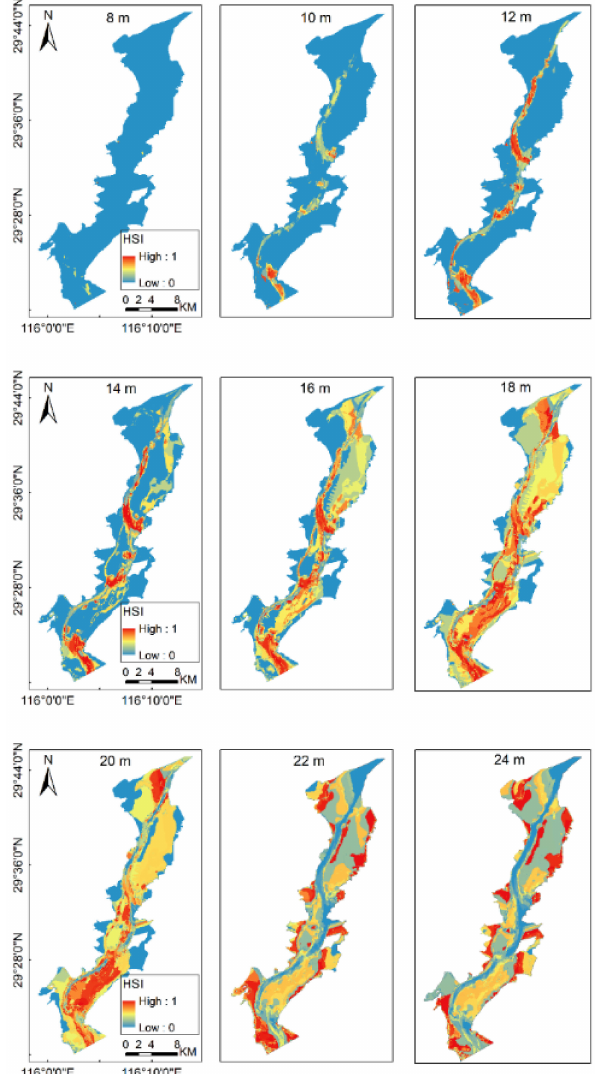
Figure 8. Mapping the I for the migratory fish under the nine typical water-level conditions (indicated in the top and middle of each